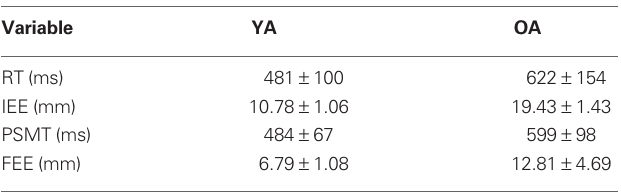
Table 1 | Older adults did not perform at the same level as young adults (all variables significantly different between the two age groups at p <